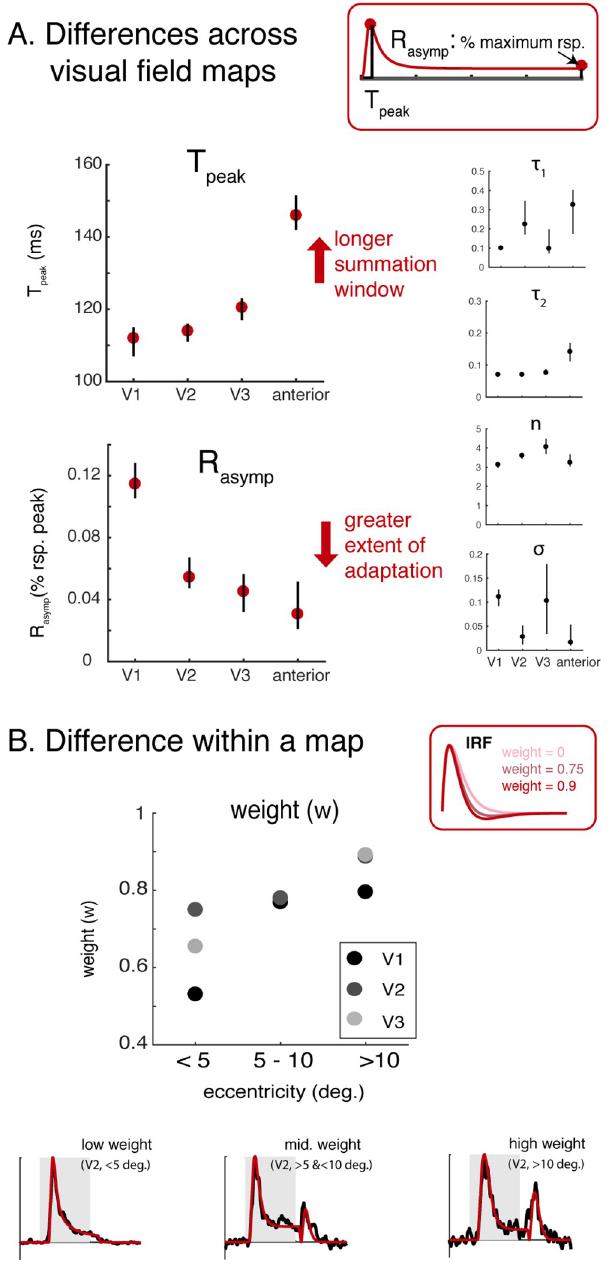
Fig 4. The DN model captures difference of temporal dynamics at different cortical locations. (A) Temporal summation window length and the extent of gain control increase along the visual hierarchy. The model parameters fit to the data are shown on the right. The model fits were then summarized by two metrics. Tpeak is the duration from the onset of a sustained stimulus to the peak response, excluding the onset latency. Tpeak is longer for later ROIs, ranging from ~115 ms (V1) to ~145 ms (anterior ROIs). Rasymp is the level at which the response asymptotes for a sustained stimulus, as a fraction of the peak response. A smaller Rasymp indicates a greater extent of gain control. Rasymp is largest in V1 (~0.12) and declines in extrastriate areas. See S5 Fig for individual electrode results. (B) Offset response as a function of eccentricity . The lower plots show the time series and model fits to 3 example electrodes. The offset response increases from fovea to periphery. This pattern holds across all 3 ROIs, as shown in the dot plot. Each dot is the mean weight ( w ) on the negative lobe of the biphasic response. Larger values of w predict larger offset responses.